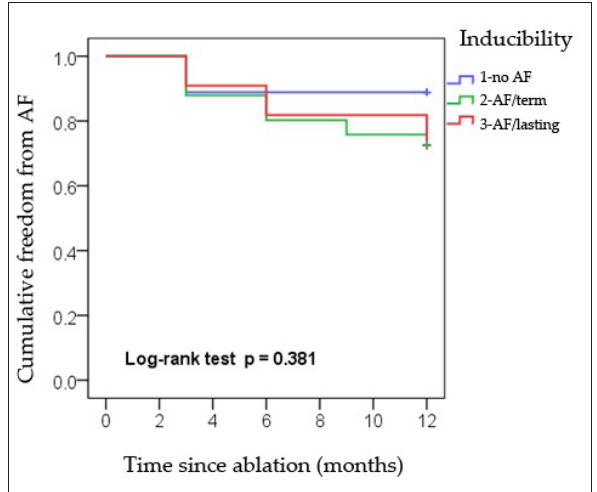
Fig. 2. Kaplan-Meier analysis of arrhythmia-free survival rate 0-12 months after